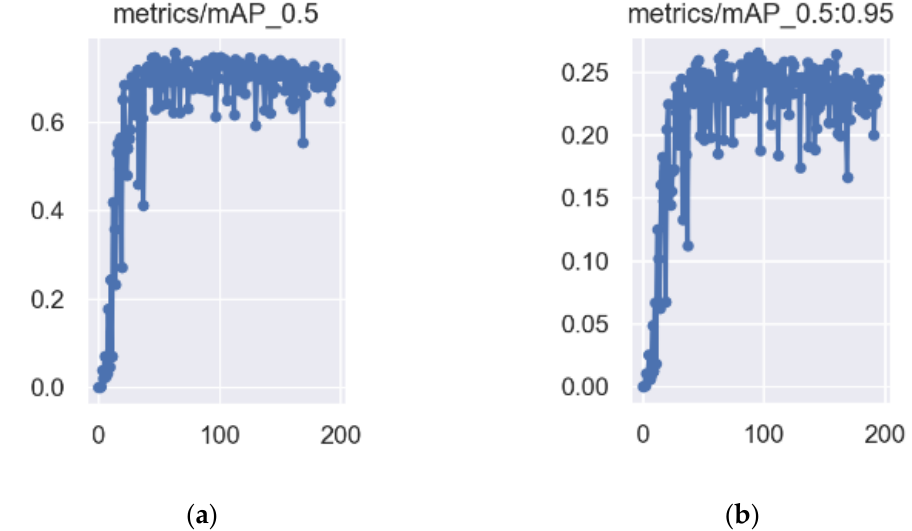
Figure A6. The change of mean average precision (mAP) of YOLOV5s: ( a ) mAP_0.5; ( b ) mAP_0.5:0.95.